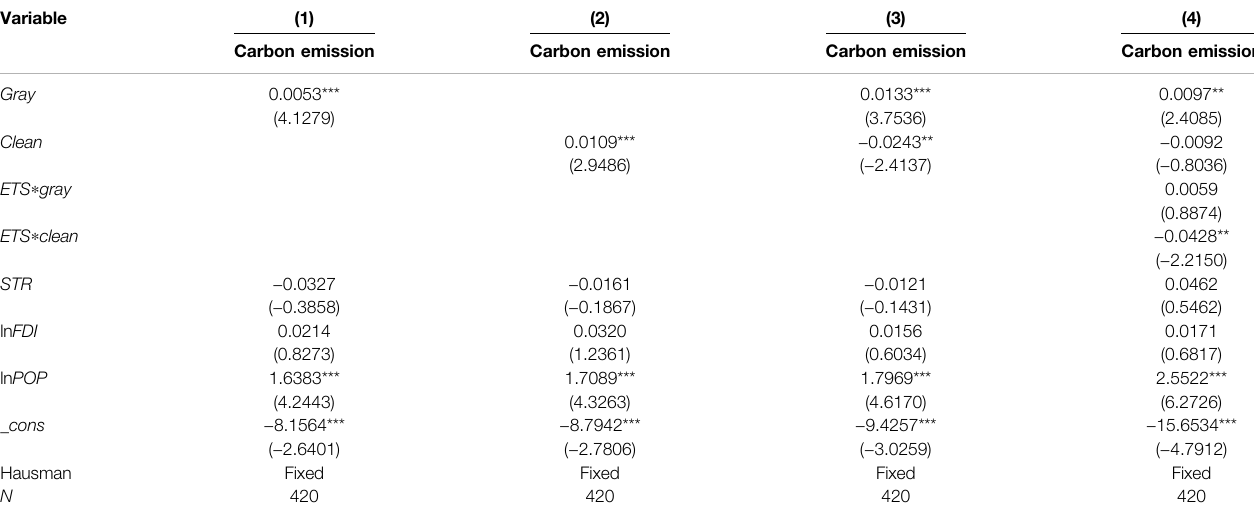
TABLE 7 | Emission reduction effects of two kinds of low-carbon technological